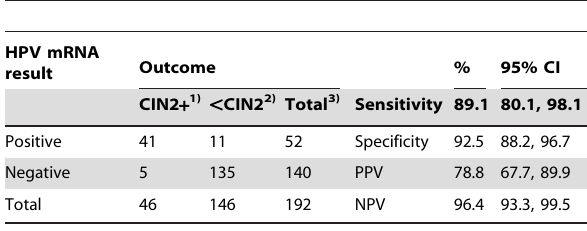
Table 4. Outcome for the 192 women in the HPV group if triaged by post-colposcopy HPV mRNA only.